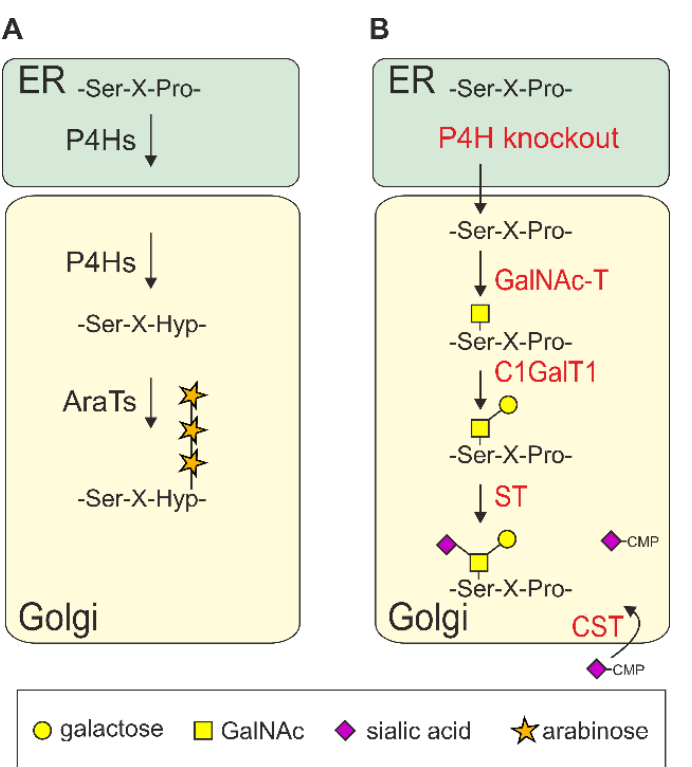
Figure 3. Schematic overview of natural and engineered O- glycosylation pathways. ( A ) Plant-type O -glycosylation. Proline residues next to Ser/Thr residues can be converted to hydroxyproline (Hyp) by prolyl-4-hydroxylases (P4Hs). Hyp residues are further elongated by arabinosyltransferases (AraTs). ( B ) Engineered mammalian-type O -glycosylation. The knockout of P4Hs prevents Hyp formation [67]. Expression of polypeptide GalNAc-transferases (GalNAc-T), β 1,3-galactosyltransferase 1 (C1GalT1), sialyltransferase (ST), the Golgi CMP-sialic acid transporter (CST), and proteins for CMP-sialic acid biosynthesis (not shown) results in mucin-type O -glycan formation